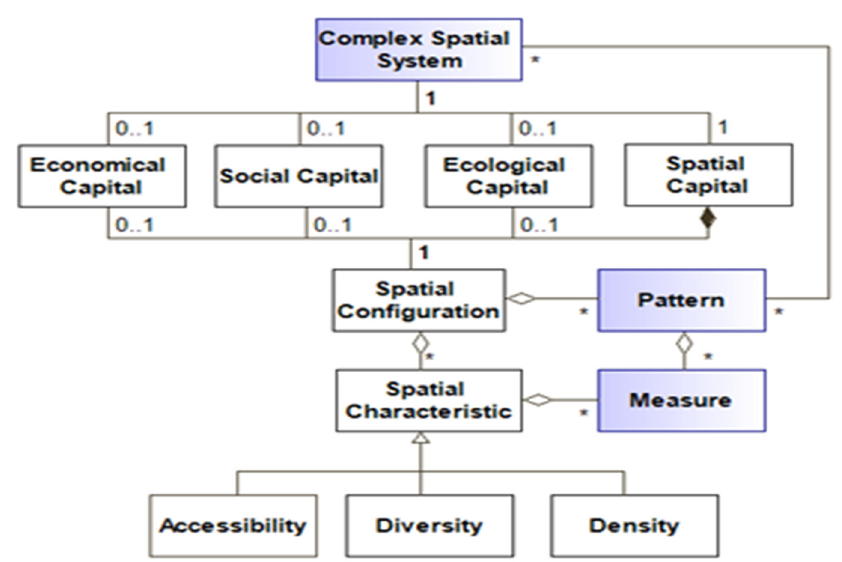
Figure 2. General model to address CSS problems that need analytical approach (UML class dia- gram).